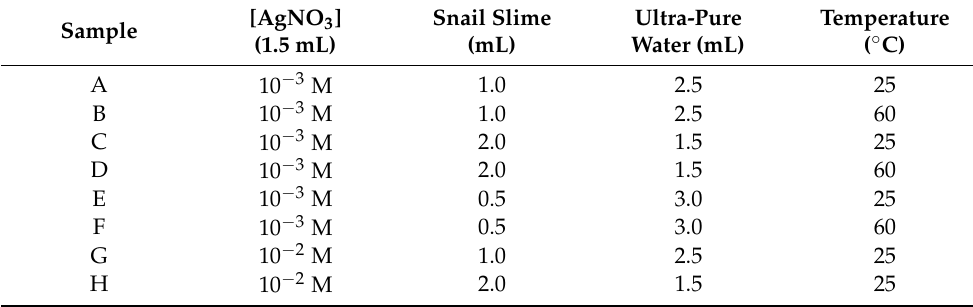
Table 2. Amount of reagents and temperature conditions used for each